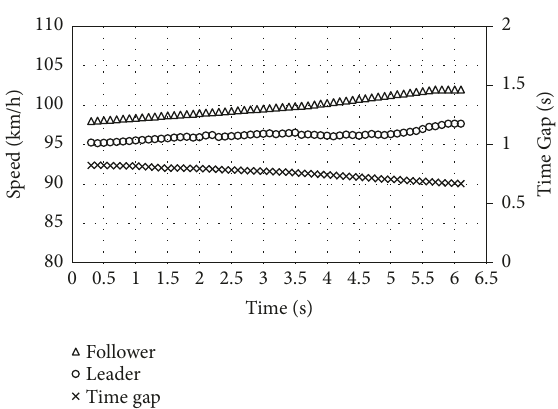
Figure 1: Typical analyzed events. (a) Speed interval [90,108[ .